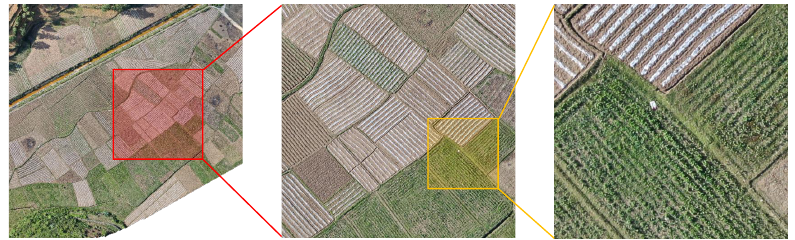
Figure 1. Ultra-high-resolution crop remote sensing